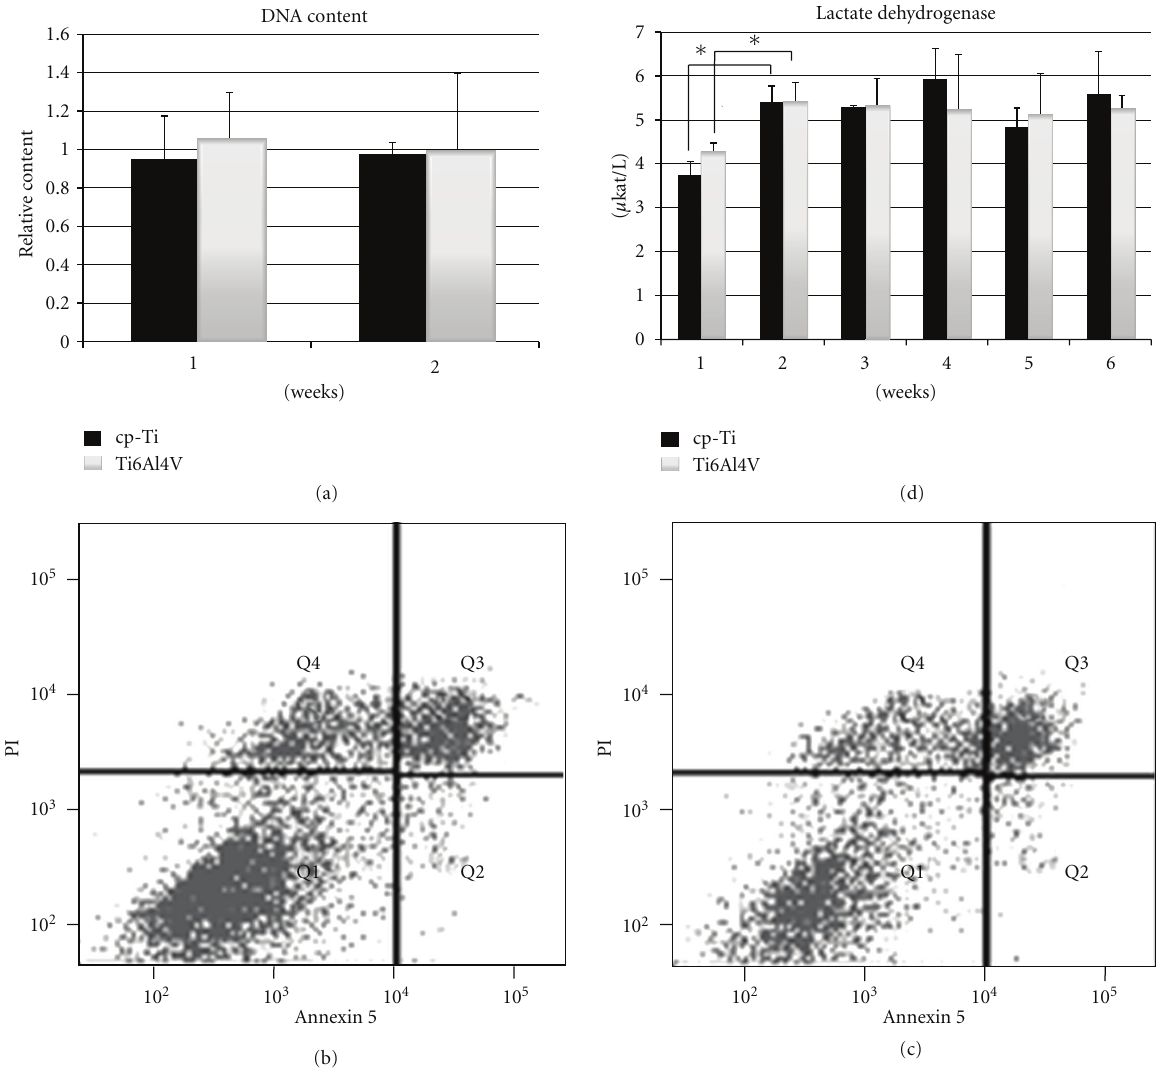
Figure 4: (a) Histograms showing the content of DNA for both constructs after 1 and 2 weeks of culture. (b-c) Flow cytometry plots displaying the proportion of viable (Q1), apoptotic (Q2, Q3), and dead (Q4) cells are shown for cp-Ti (b) and Ti6Al4V (c) constructs. (d) Histograms showing the LDH activity for both constructs along the entire duration of the experiment. A value of P < 0 . 05 was taken as a significant di ff erence ( ∗